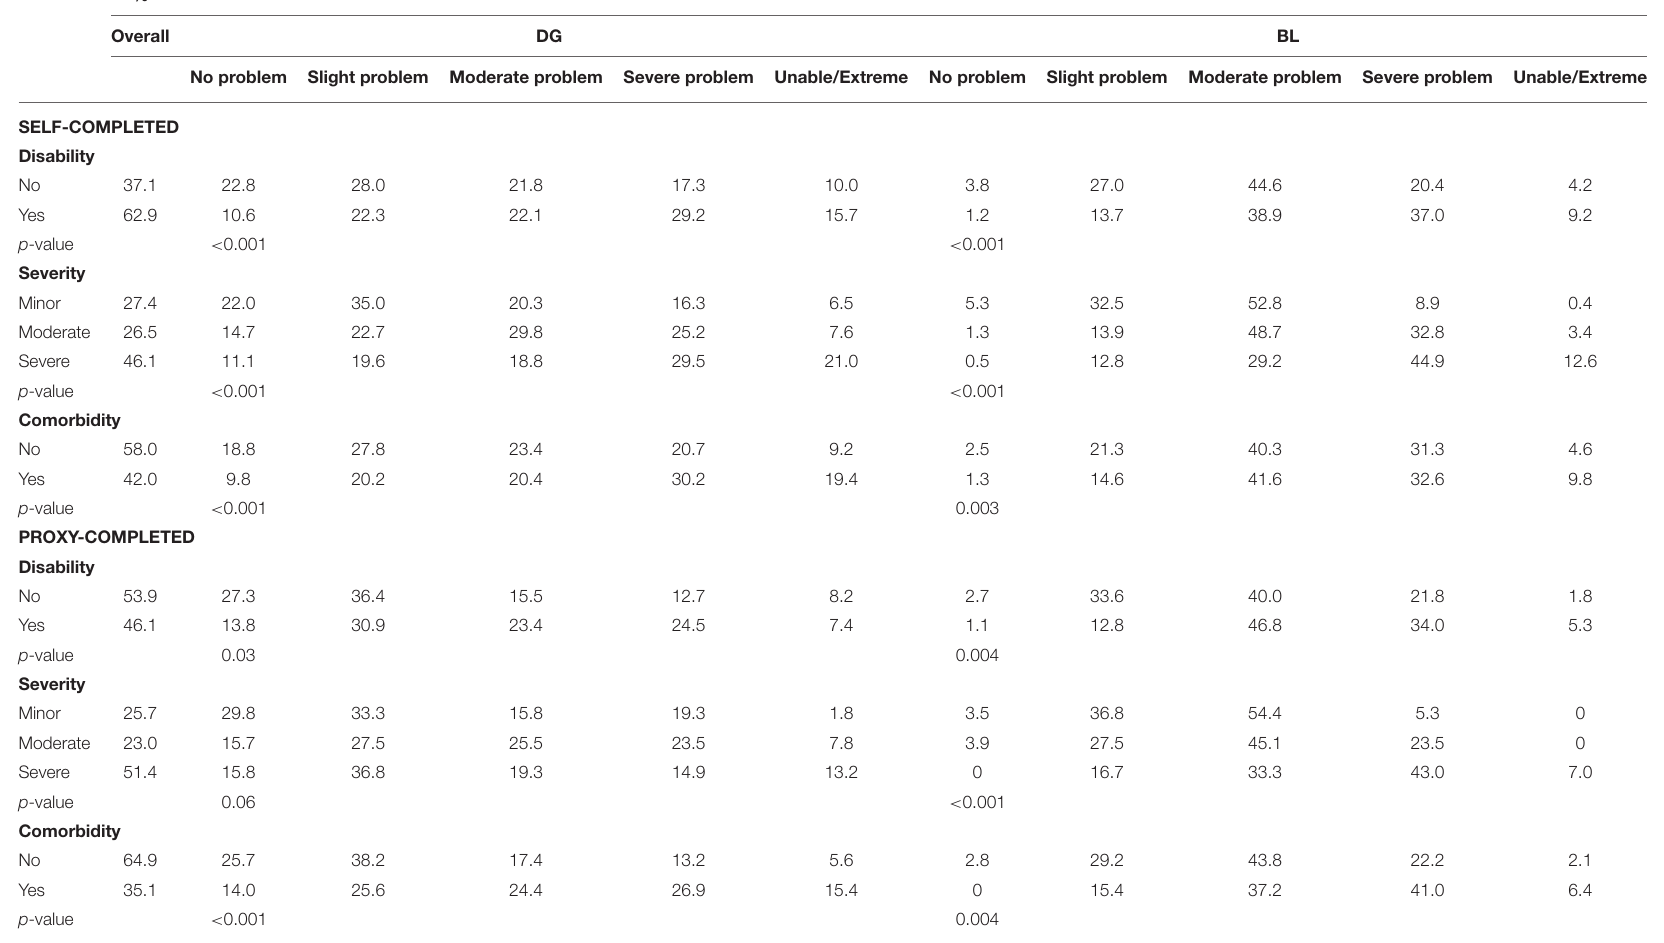
TABLE 5 | Summary of known-groups validity testing of the two bolt-on items. % Overall DG